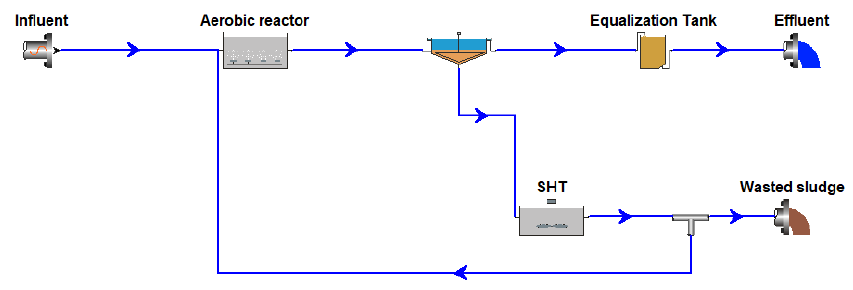
Figure 3. A schematic presentation of BioWin plant configuration.